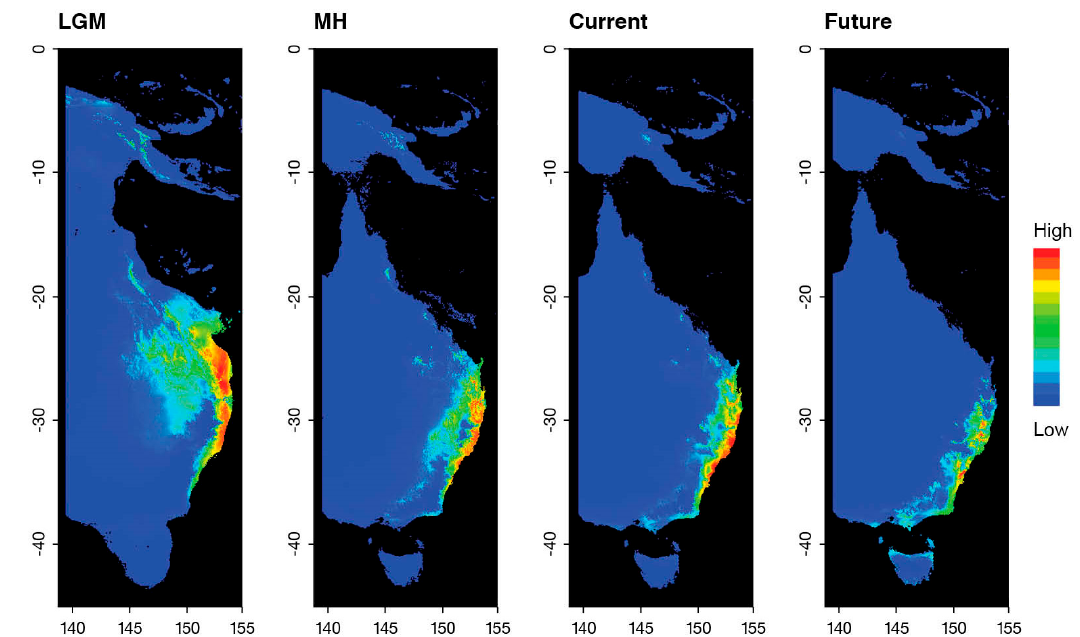
Figure 8. Environmental niche modelling (ENM) for Ficus coronata during Last Glacial Maximum (LGM 22,000 ybp), Mid Holocene (MH 6000 ybp), Current era and Future (2050). Red shows the most favourable habitat and blue the least.